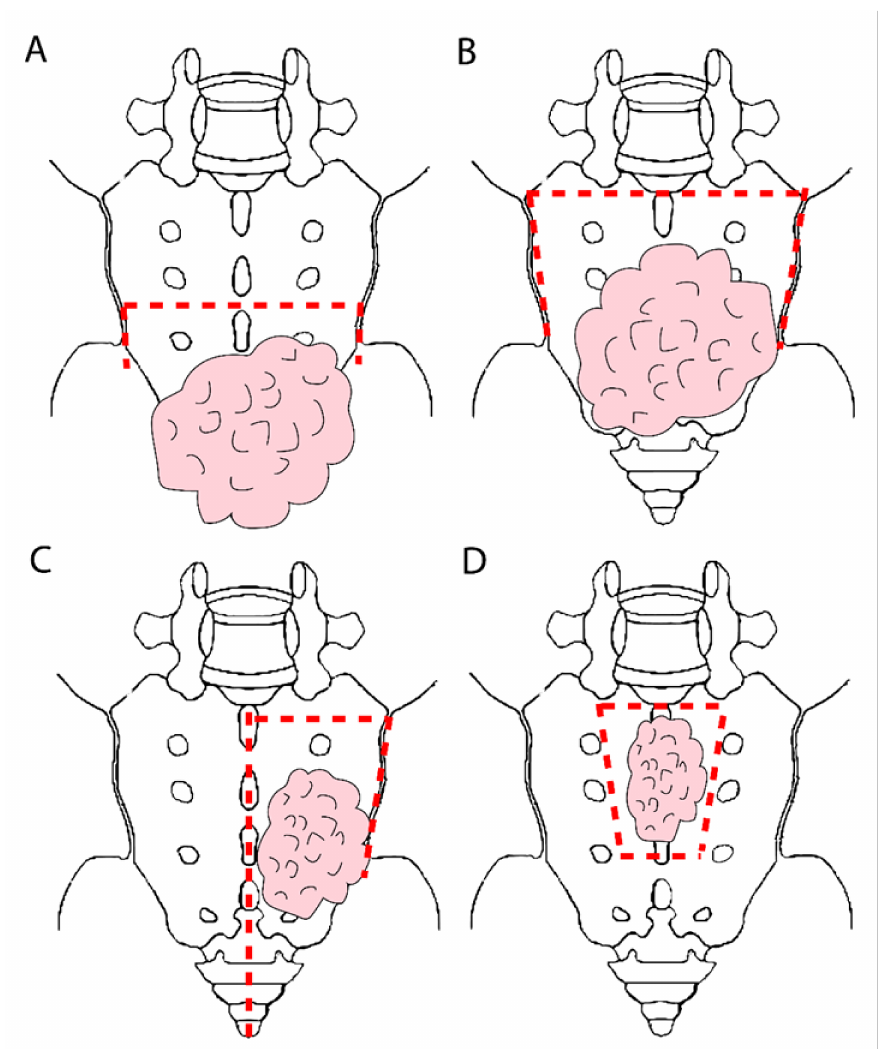
Figure 1. Approaches to en bloc sacral resection depending on the site of invasion of the rectal tumour. Dashed red lines denote resection margins. ( A ) Low sacrectomy involves sacral transection in the axial plane below the S2 foraminae. ( B ) High sacrectomy involves sacral transection at or above the S2 foraminae and involves disarticulation from sacroiliac joints. ( C ) Hemisacrectomy involves tumours not crossing the midline of the sacrum, thus, leaving the contralateral side intact. ( D ) High subcortical sacrectomy (HISS) or anterior table sacrectomy is reserved for tumours adherent to the median sacral plane but not involving the sacral foraminae laterally, and the anterior sacral cortex only is